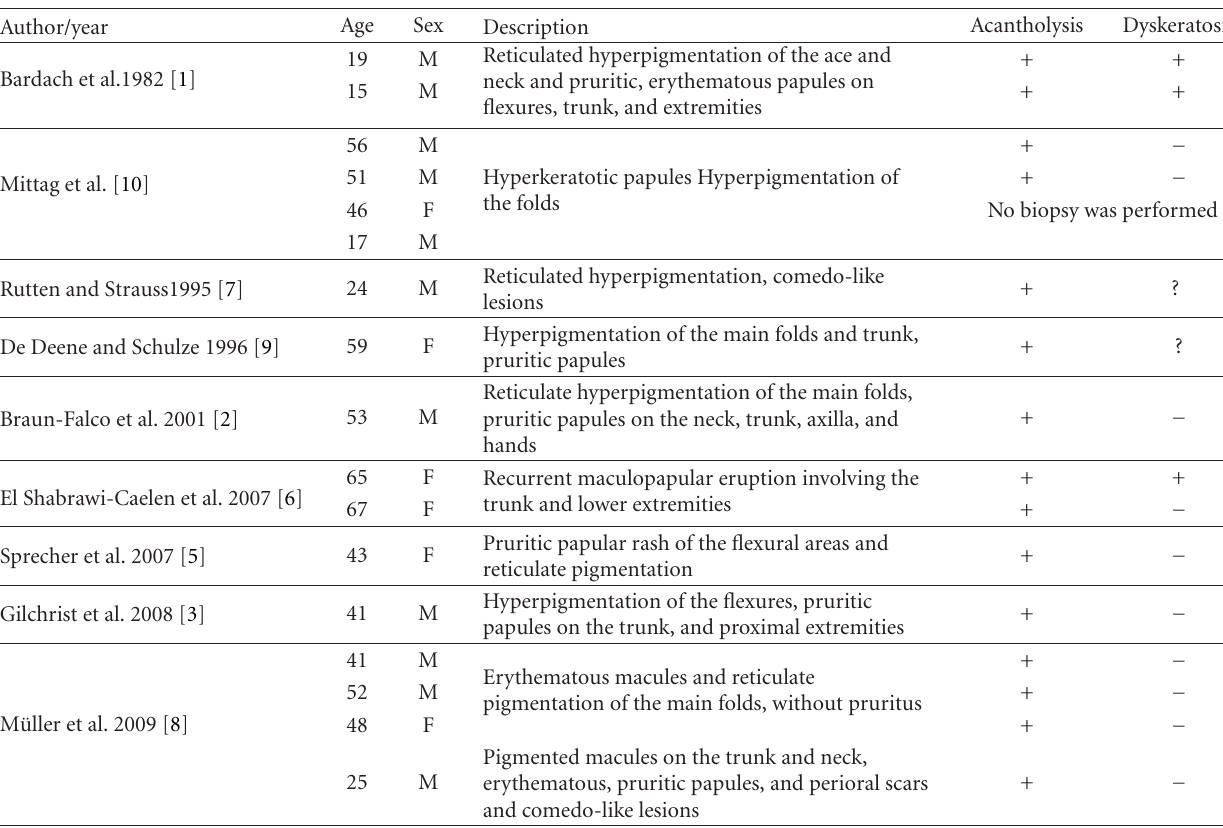
Table 1: Reported cases of Galli-Galli